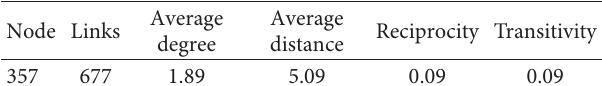
Table 3: Descriptive statistics of the Tianjin Port blast response network structure.